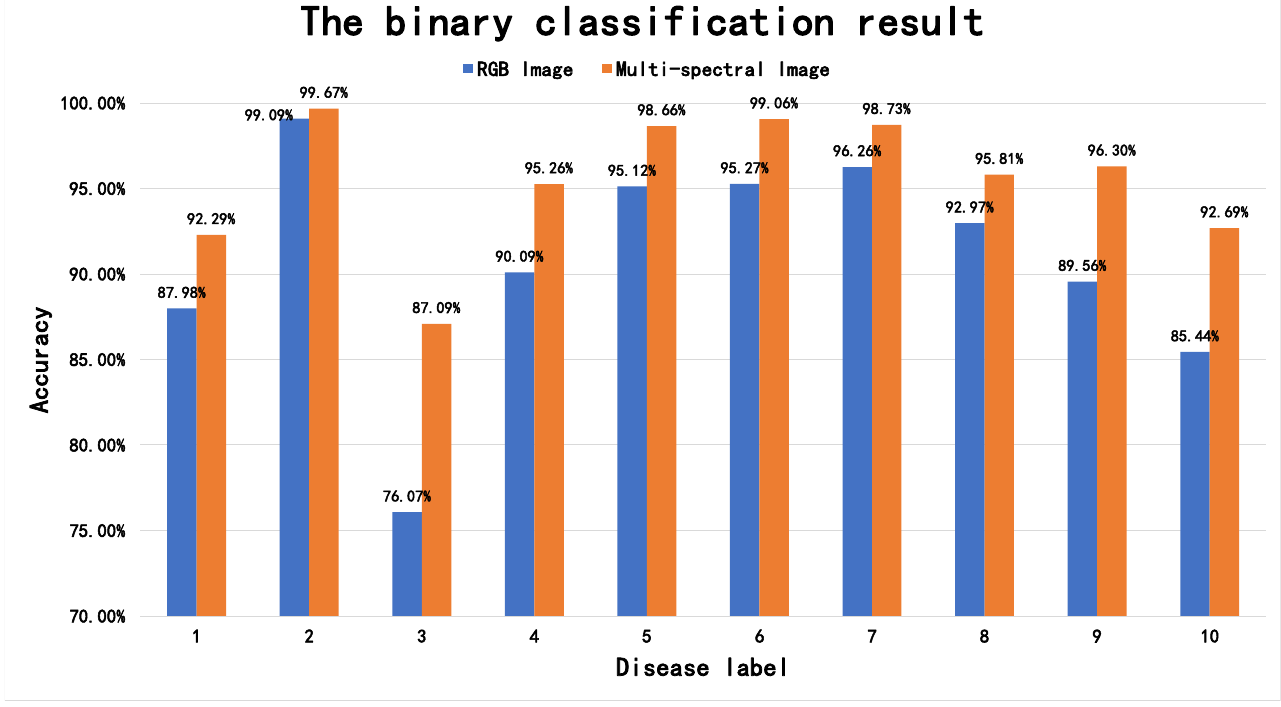
Figure 4. Binary classification results of the multi-spectral image feature fusion and corresponding RGB image classification algorithms. The corresponding relationship between the disease label serial number and the disease category is as follows: 1: AV (VS normal flora), 2: BV (VS normal flora), 3: VVC (VS normal flora), 4: flora inhibition (VS normal flora), 5: BV + AV (VS normal flora), 6: BV middle (VS normal flora), 7: BV middle + VVC + AV (VS normal flora), 8: BV middle + VVC (VS normal flora), 9: AV + TV (VS normal flora), 10: abnormal flora combined clinically (VS normal flora). Table 5. Comparison with RGB Image in more CNN-based models (multiple-label